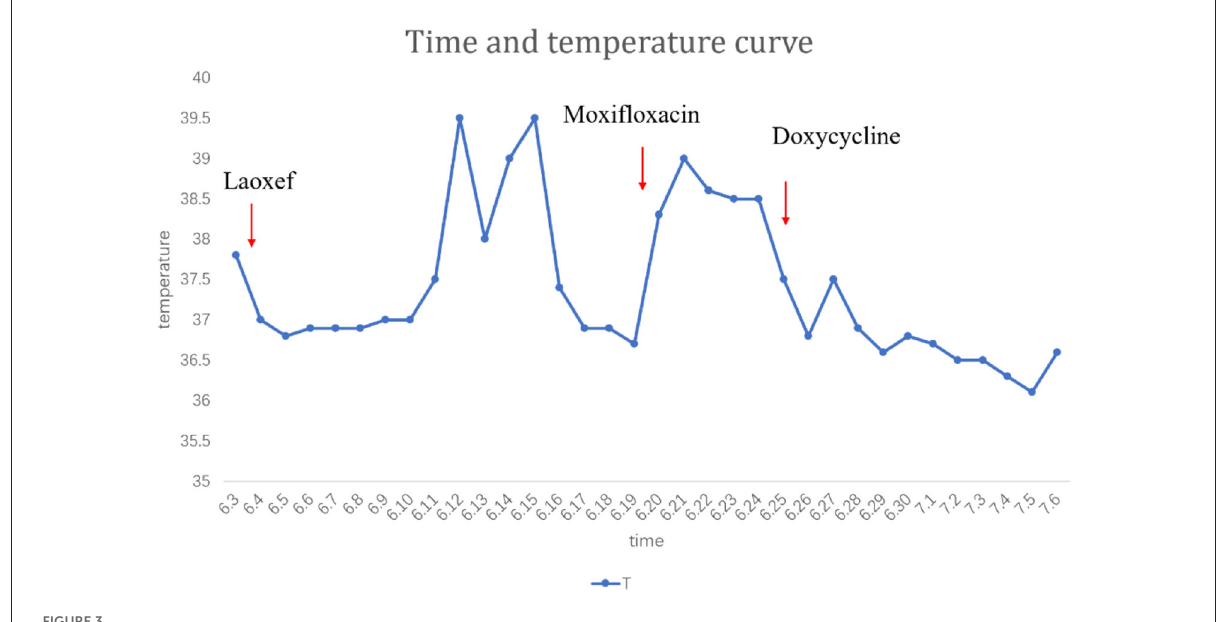
FIGURE3 The temperature during his